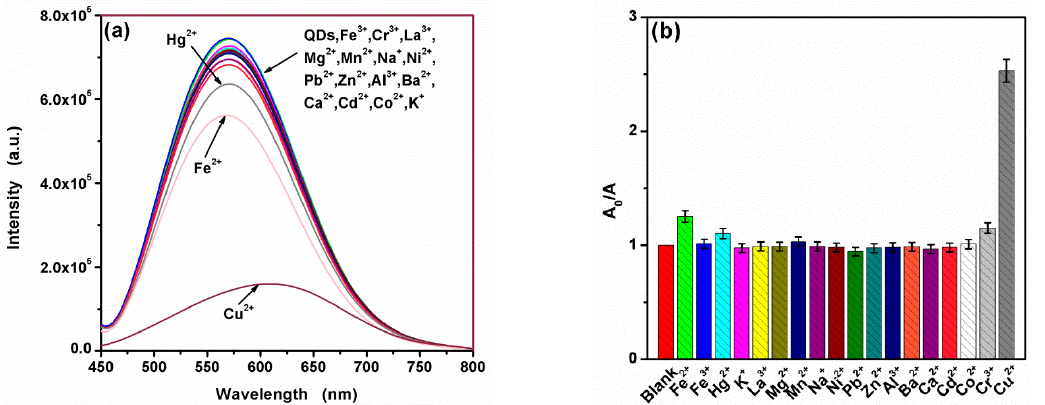
Figure 6. ( a ) Effect of various metal ions to fluorescence spectra of CA-CdS QDs and ( b ) relative fluorescence area (A 0 /A) of CdS QDS with various metal ions at a concentration of 50 µ